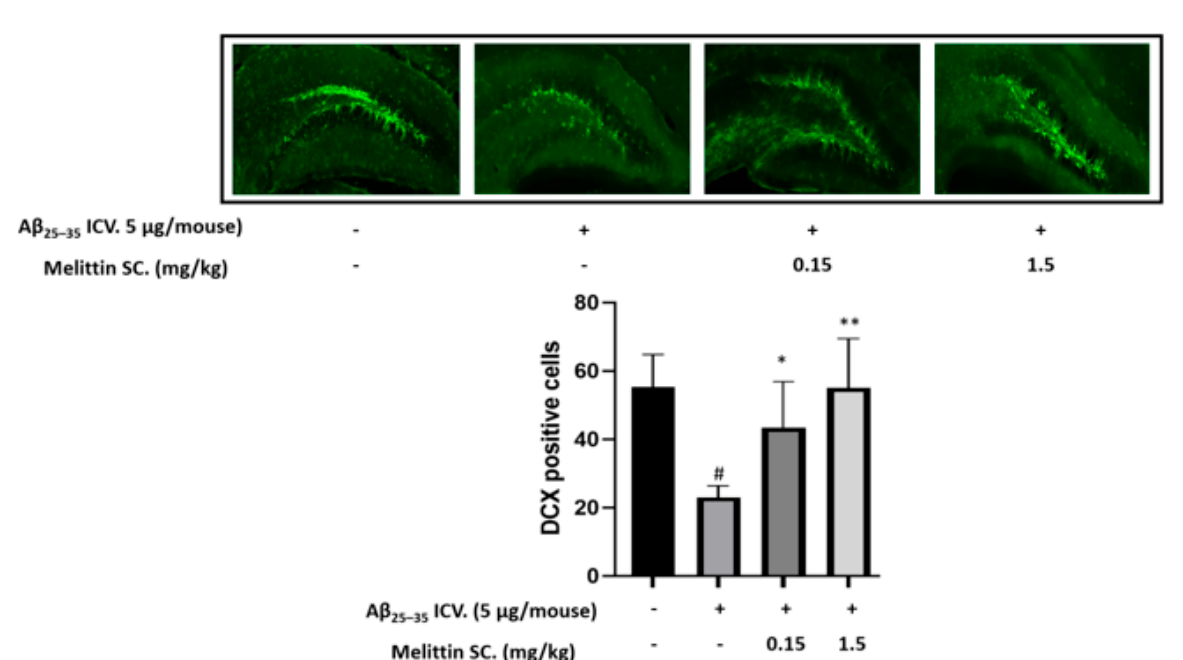
Figure 7. Protective effect of melittin on neuronal cells in the dentate gyrus region against A β 25–35 induced stress. The result indicated that A β 25–35 ICV. treatment reduced neuron cell neurogenesis significantly, and this was reversed by melittin. To conduct this experiment: Brain sections stained with doublecortin antibody, and the hippocampal dentate gyrus area were examined. Data are presented as the mean ± standard error of the sextuple determinations. # p < 0.01 vs. control * p < 0.05 and ** p < 0.01 vs. A β 25–35 only-treated group.